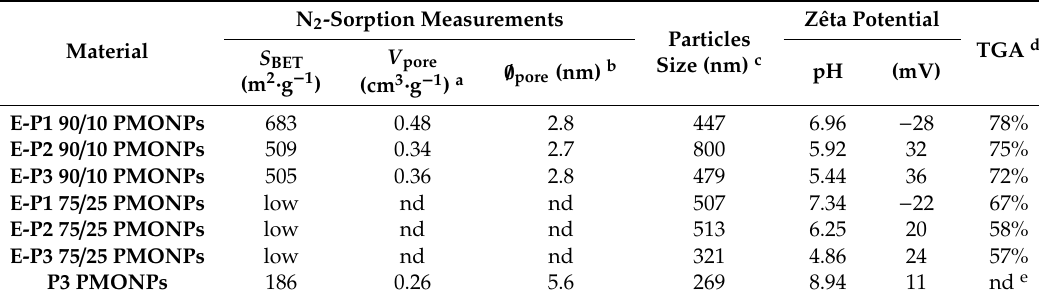
Table 1. Some physical data of E-Pn PMONPs and P3 PMONPs .